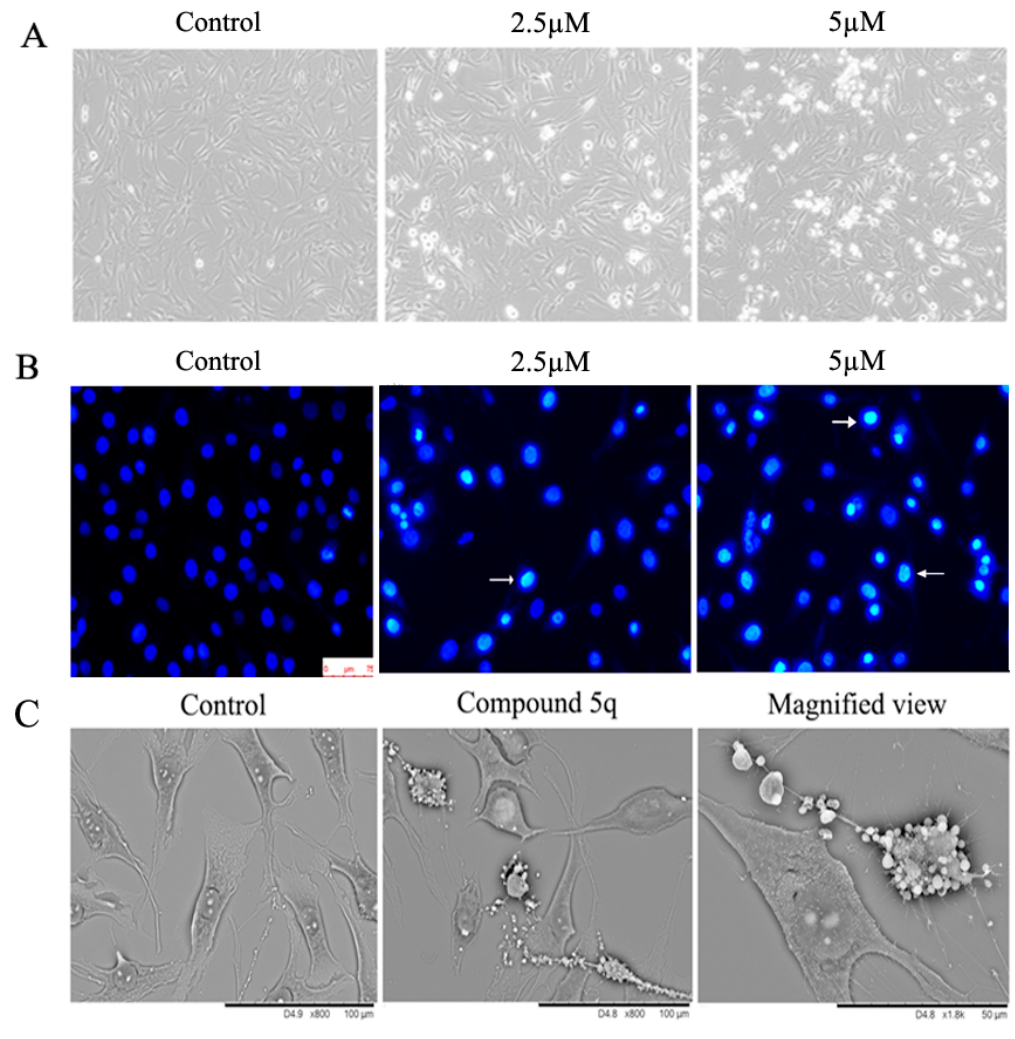
Figure 2. Morphological observation of 5q -induced apoptosis in MG63 cell. ( A ) MG63 cells were exposed to 5q for 24 h and optical microscope was used for morphological analysis; ( B ) Fluorescent micrographs of 5q -treated and untreated MG63 cells after 4,6-diamidino-2-phenylindole (DAPI) staining. MG63 cells treated with 0, 2.5, and 5 µ M 5q for 24 h, were subjected to DAPI staining and then viewed under a fluorescent microscope at magnification of 200. Arrows indicate apoptotic characteristics of treated cells; and, ( C ) screening electron microscope (SEM) micrographs of 5 µ M 5q -treated MG63 cells for 24